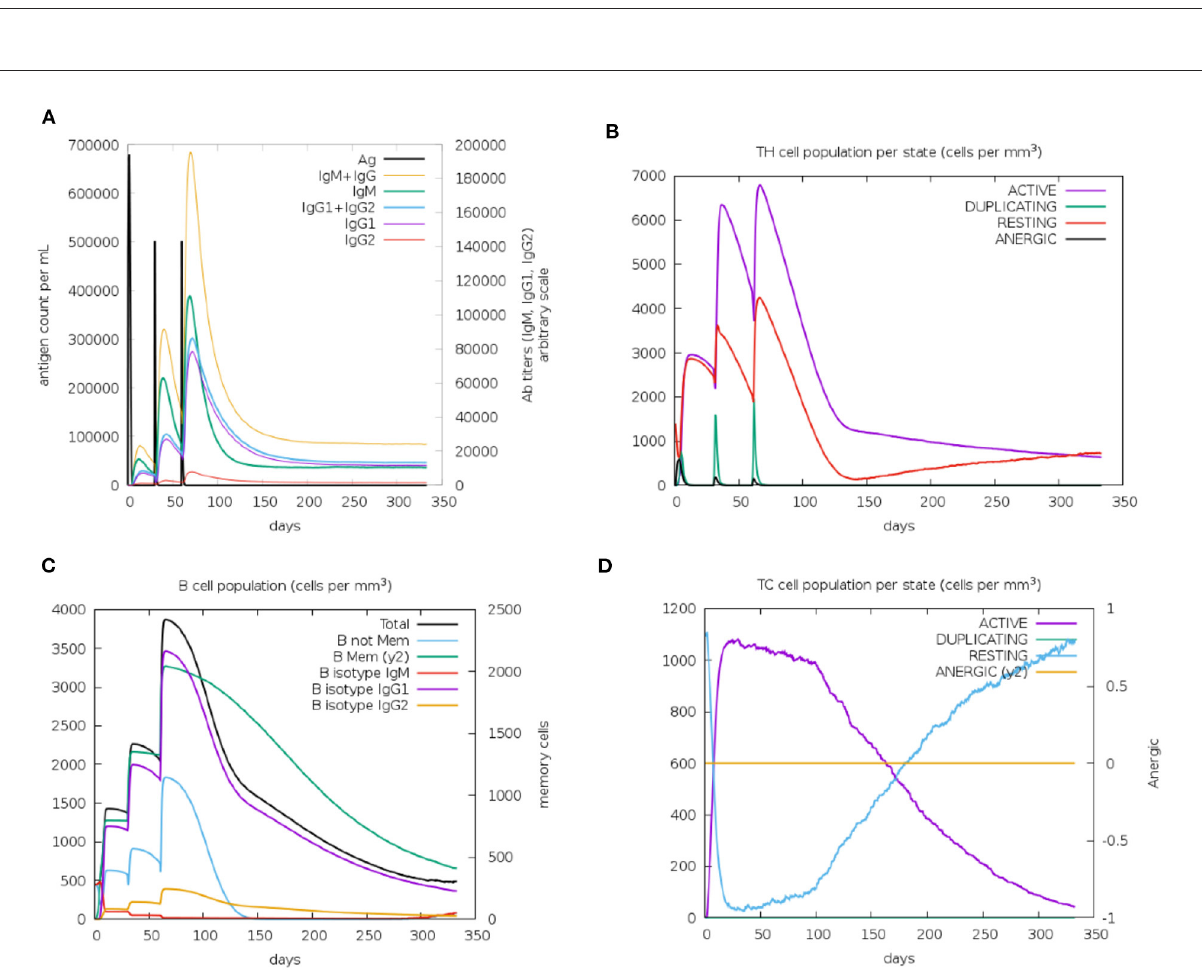
FIGURE9 Simulated immunity of vaccine constructs using C-ImmSim server showing (A) an increase in immunoglobulins following vaccination (B,D) , that the population of cytotoxic T-lymphocytes and helper T-lymphocytes increases after vaccination and remains higher during the entire exposure time, and (C) an increase in B-cell populations after vaccination, producing high levels of memory